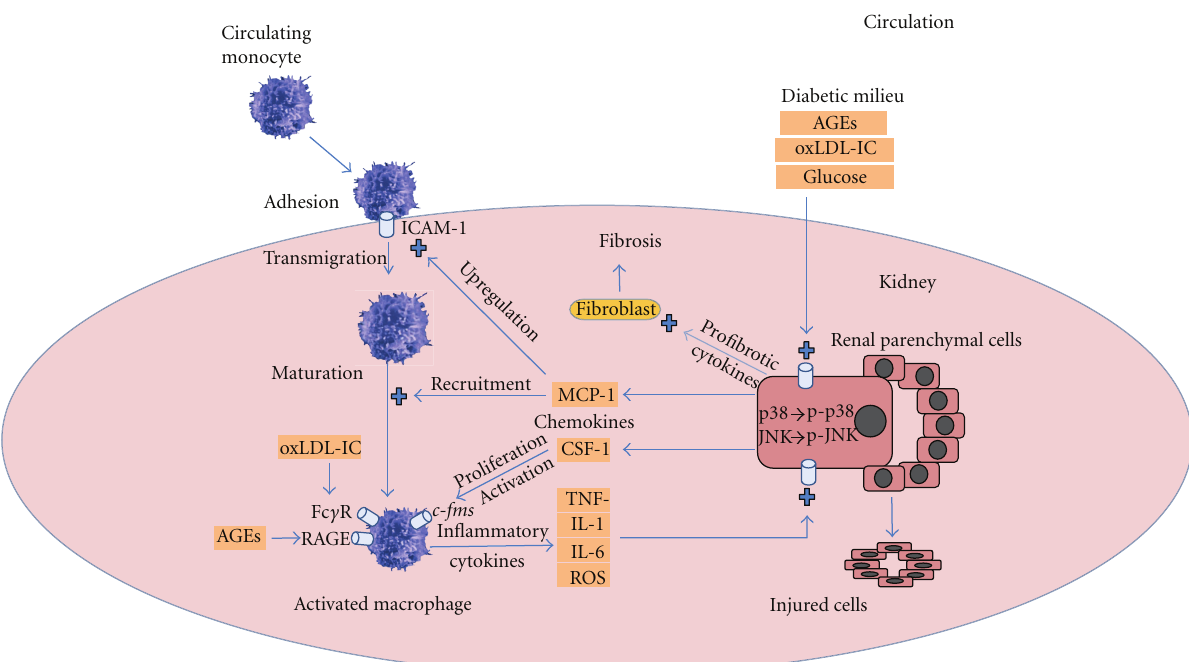
Figure 1: The inflammatory amplification loop in the diabetic kidney. Circulating immune cells such as monocytes are recruited into the diabetic kidney due to upregulation of adhesion molecules such as ICAM-1. Chemokines such as MCP-1 act as chemoattractants which promote accumulation of the immune cells in the kidney. These immune cells are activated by numerous signals such as the ligation of c-fms by CSF-1, receptor for AGE by AGEs, and the Fc γ receptors by antioxidized LDL immune complexes. CSF-1 also promotes the maturation, proliferation, and survival of monocyte-macrophages. Activated immune cells act as inflammatory cells and elaborate proinflammatory cytokines and reactive oxygen species (ROS), which trigger a cell signalling cascade mediated by the stress-activated protein kinases, p38 MAPK, and JNK. These kidney cells then respond by the production of chemokines such as MCP-1 and CSF-1, and profibrotic factors such as TGF- β which increase extracellular matrix production by mesangial cells and interstitial fibroblasts. Ultimately, there is cellular injury and progressive fibrosis within the diabetic